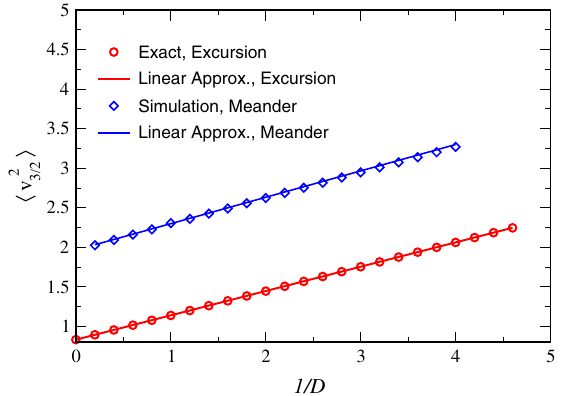
FIG. 6. The variance of the area under the Bessel excursion 2 i and hð v 2 i and meander, hð v 3 , versus 1 =D . The exact 3 = 2 Þ = 2 Þ M solution for the excursion [67] is well approximated by Eq. (70) and the simulation for the meander with Eq. (71) (averages over 2 × 10 5 particles and τ ¼ 10 5